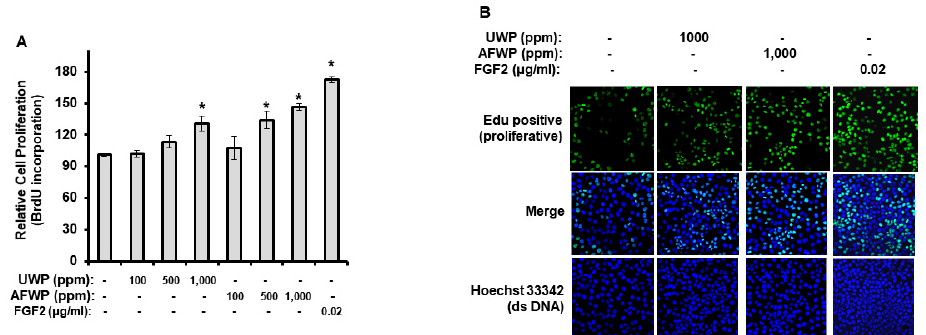
Figure 2. Effects of AFWP on cell proliferation potential. HaCaT cells were incubated with AFWP for 48 h. After incubation, cell proliferation was measured using BrdU cell proliferation assay ( A ) and Edu imaging analysis ( B ). Fibroblast growth factor 2 (FGF2) was used as a control compound. The results were confirmed using four independent experiments. Each experiment was conducted in duplicate. All data are presented as the mean ± SEM of four independent experiments. Statistical significance of differences among the groups was assessed by ANOVA, followed by Tukey’s multiple- comparison test, using the GraphPad Prism 5 software. * p < 0.05 vs. control group. AFWP: Aspergillus oryzae-fermented wheat peptone, UWP: unfermented wheat